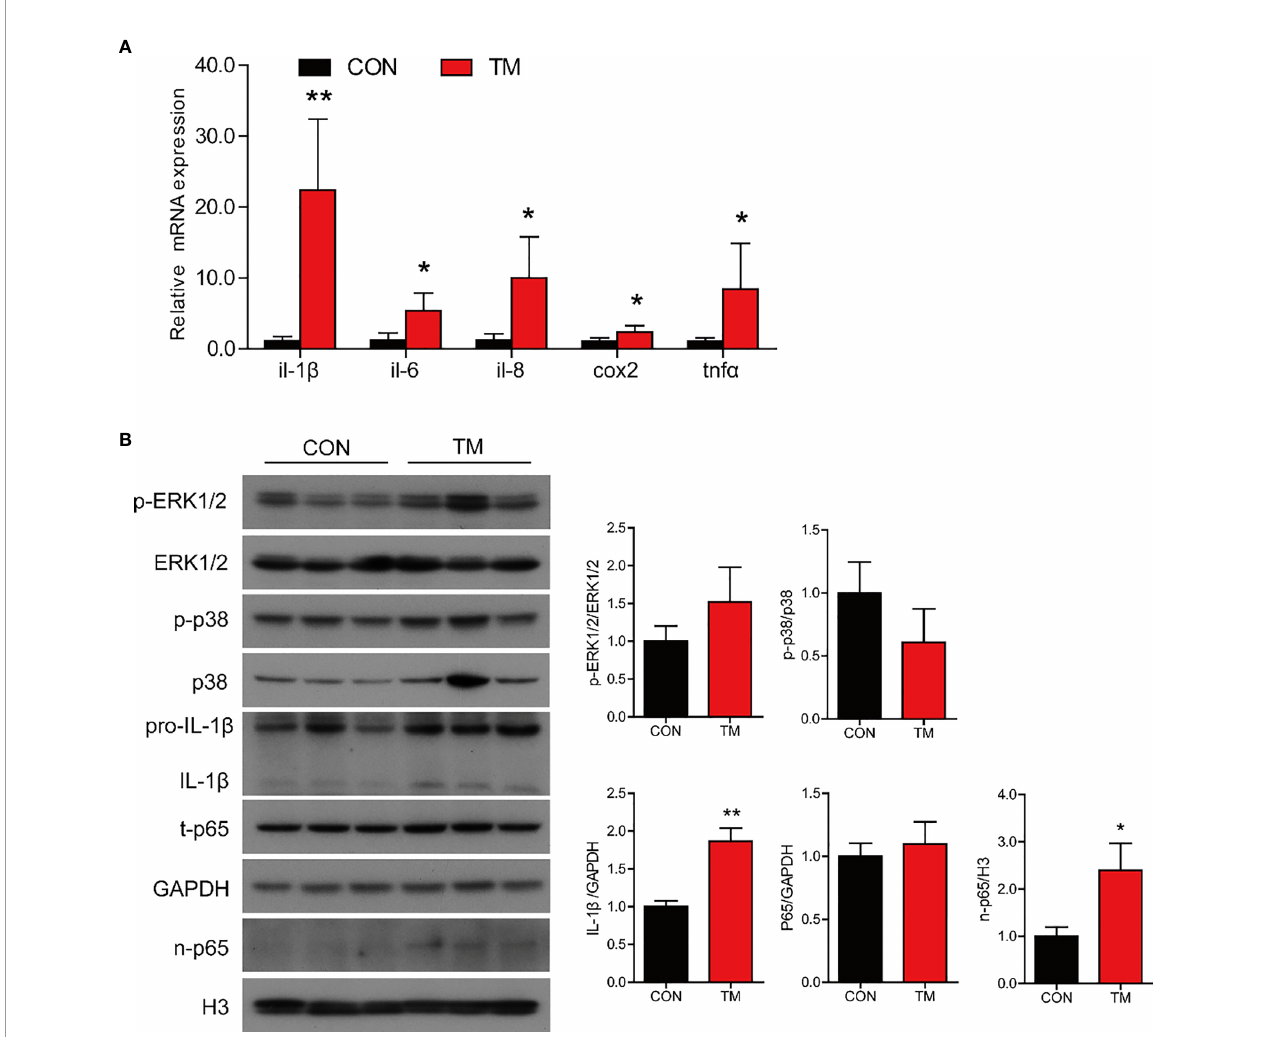
FIGURE 3 | ER stress augments in fl ammatory response in the intestine of large yellow croaker in vivo . (A) Relative mRNA expression of in fl ammation-related genes in the intestine of large yellow croaker after TM injection for 24 h (n = 6). (B) Western blot analysis of in fl ammation-related protein levels in the intestine of large yellow croaker after TM injection for 24 h (normalized to GAPDH, n = 3). il-1 b , interleukin-1 beta; il-6 , interleukin-6; il-8 , interleukin-8; cox2 , cyclooxygenase 2; tnf a , tumor necrosis factor alpha; ERK1/2, extracellular signal-regulated protein kinases 1 and 2; p38, p38 mitogen-activated protein kinase; p65, NF-kappaB p65; GAPDH, glyceraldehyde-3-phosphate dehydrogenase. Results were analyzed using independent t -test (* P < 0.05, ** P < 0.01), and they were presented as mean ± standard